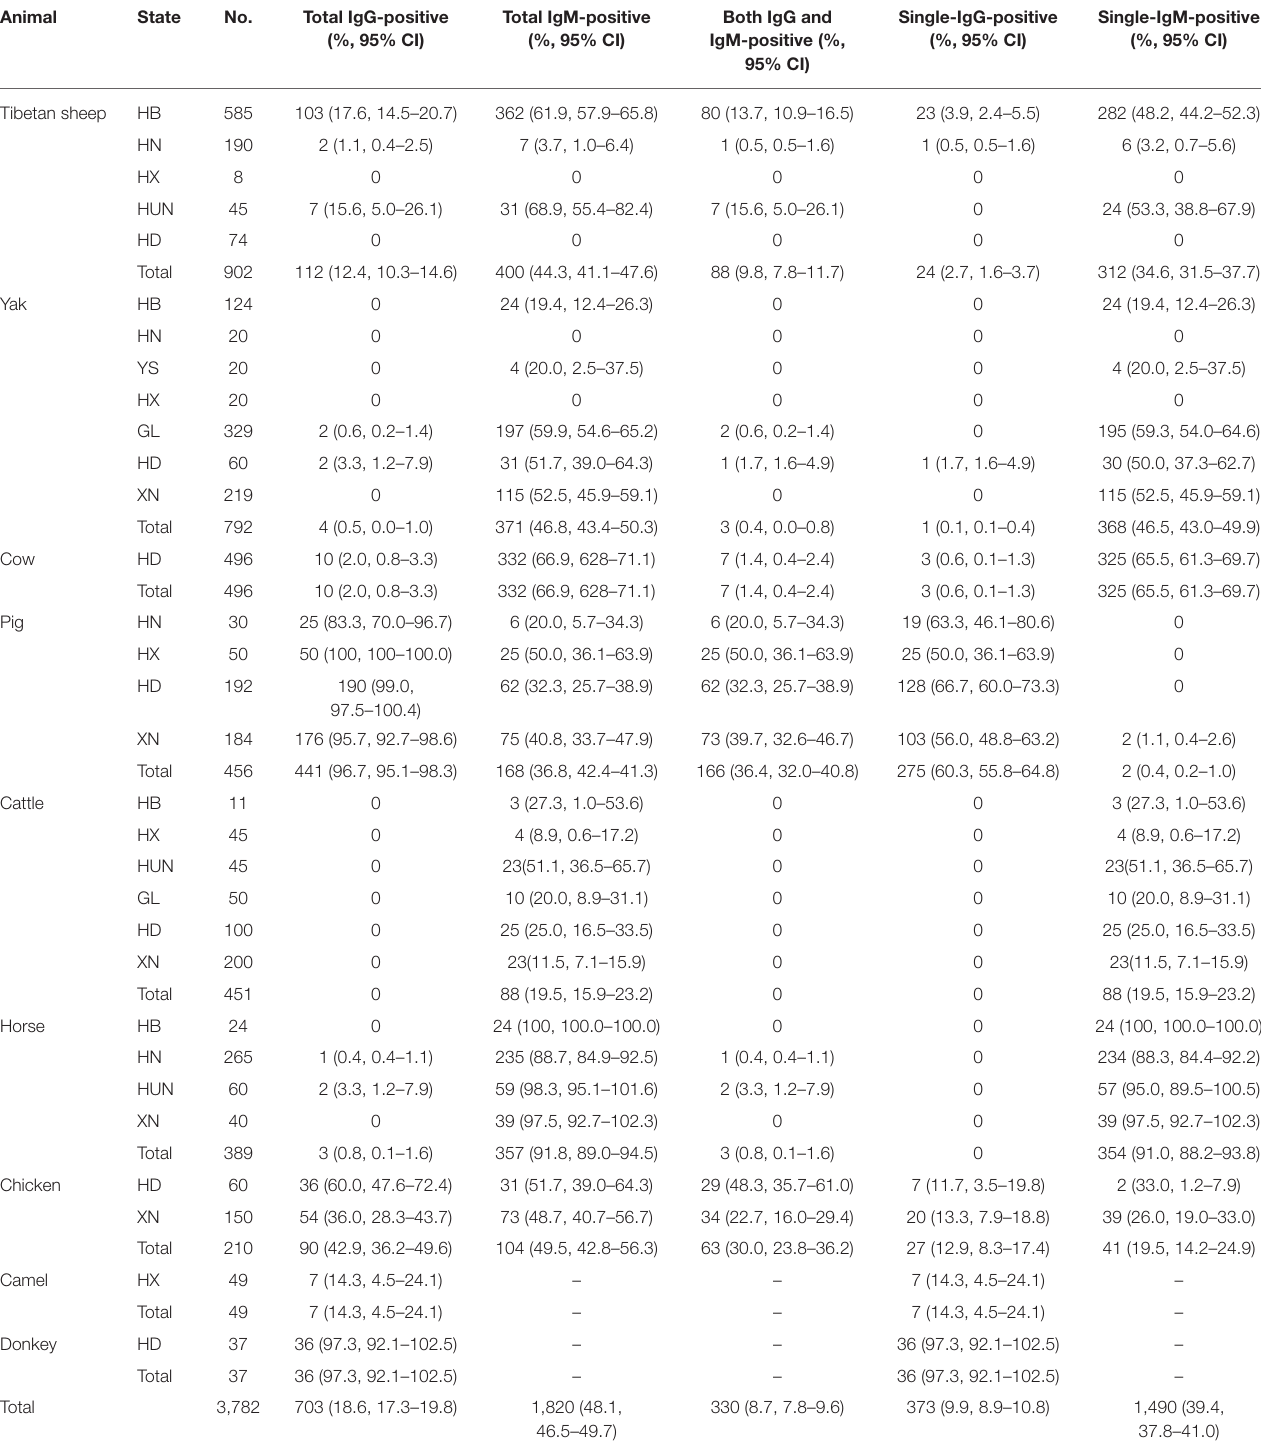
TABLE 3 | Seroprevalence of Neospora caninum- specific IgG and IgM in animals in the QTPA.